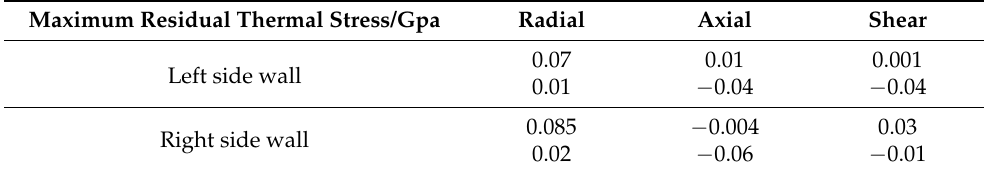
Table 7. Maximum and minimum residual thermal stresses on the sidewalls of M2S2 cracks at the “reduced to room temperature”